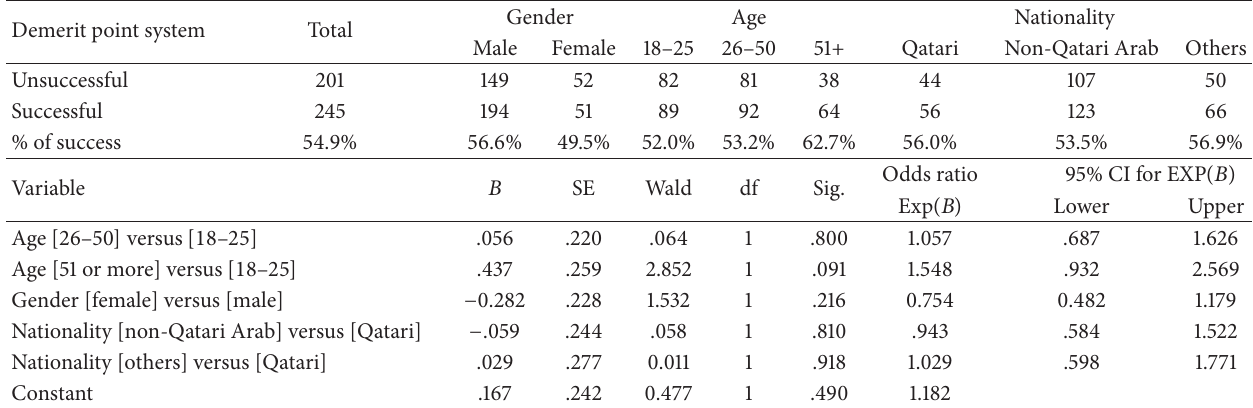
Table 7: Reported success and logistic model results for the demerit point system